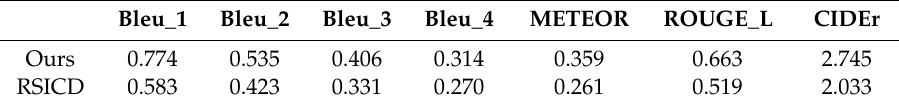
Table 3. Results comparison using VGG-19+LSTM.